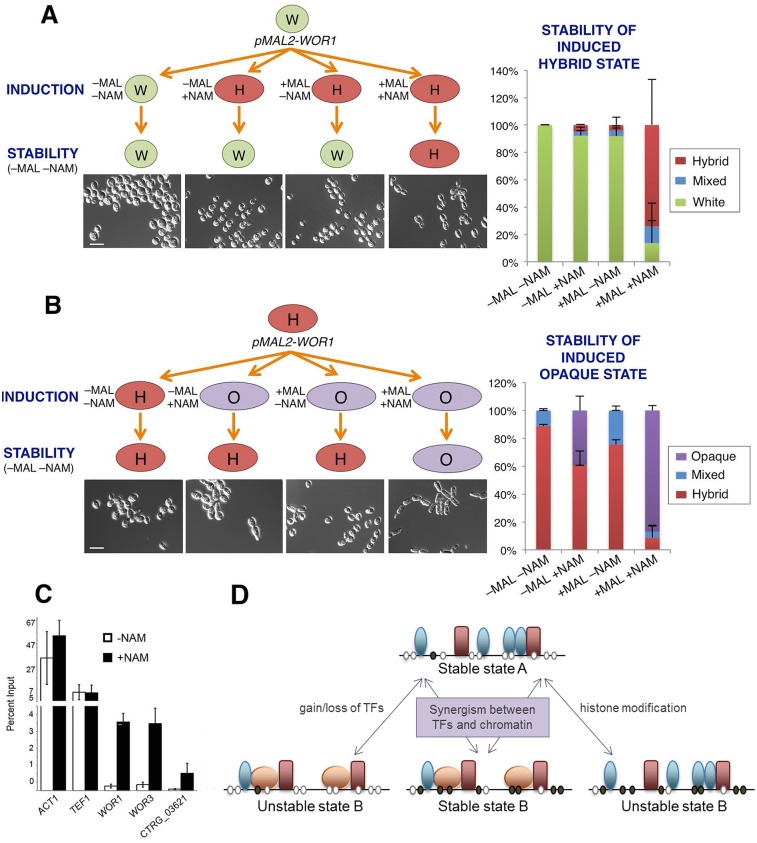
Stable switching requires both ectopic WOR1 expression and changes in chromatin structure.Cells encoding an ectopic pMAL2-WOR1 construct in (A) white cells or (B) hybrid cells were plated onto inducing (+MAL) or non-inducing (-MAL) medium. In addition, some plates were supplemented with 5 mM NAM (a histone deacetylase inhibitor). Colonies were grown at 30°C for 7 days before re-plating to media lacking both maltose and NAM and grown for a further 7 days at 30°C. Colony phenotypes were determined and quantified. (C) White cells were grown either in the presence or absence of 5 mM NAM at 30°C for 24 hours. Chromatin immunoprecipitation was performed for H3K56Ac in induced and uninduced cultures. Quantification of H3K56Ac enrichment at cell state regulators and control genes was performed by qPCR and compared to input controls for three biological replicates. (D) Model of the dual regulation of epigenetic switching by transcriptional activation and histone modification. Induction of either stimulus alone is capable of inducing state switching, but loss of the stimulus results in cells reverting to the original state. Cells experiencing both transcriptional activation and chromatin remodeling (via HDAC inhibition) are able to stably maintain the new cell state even after the removal of switch-inducing factors.